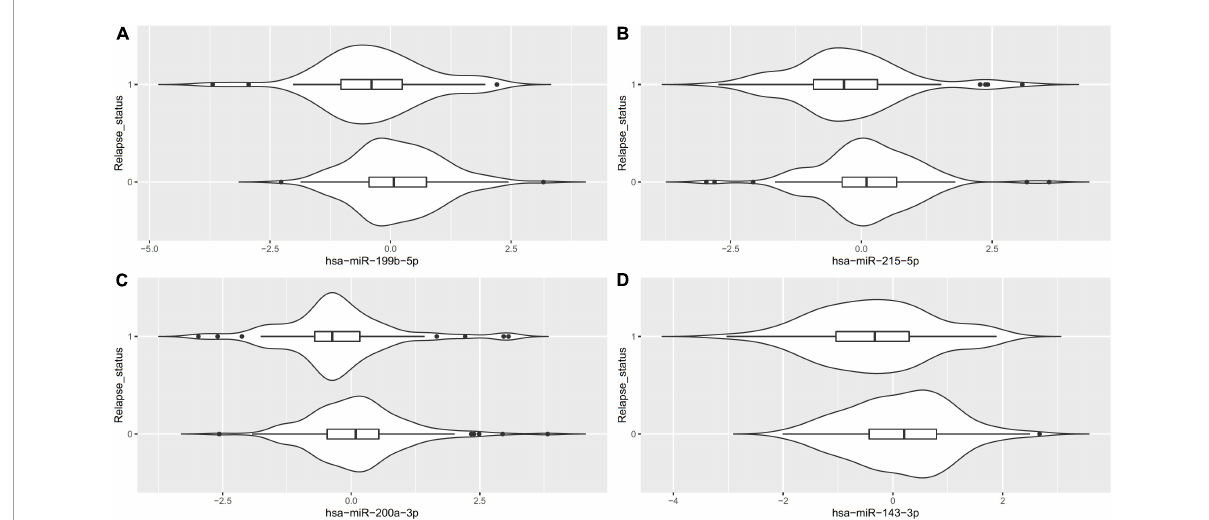
FIGURE2 Violin plots for the differentially expressed miRNA (FDR < 0.1) between patients who relapsed during the follow-up phase (1) vs. those who did not (0).